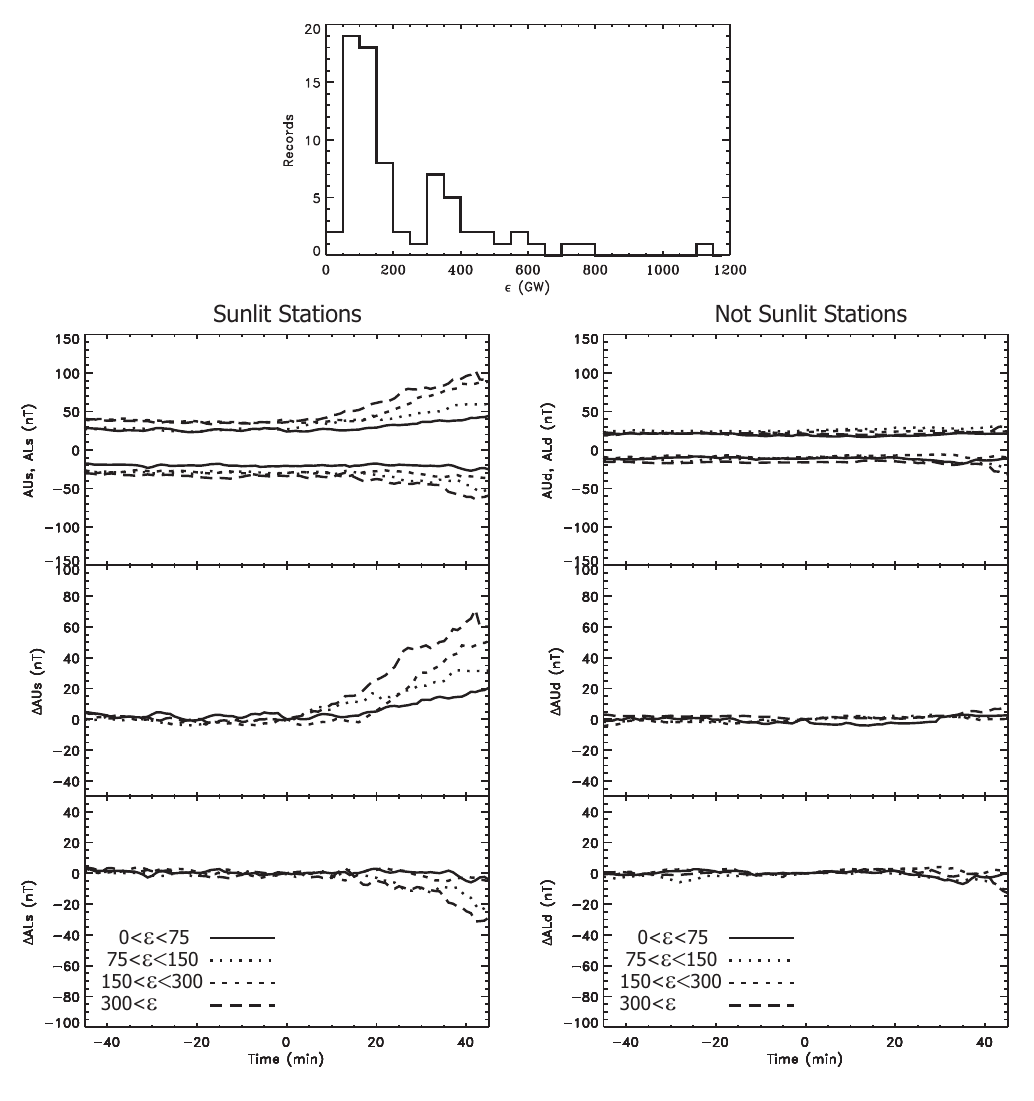
Fig. 7. Same format as Fig. 6 but for ε